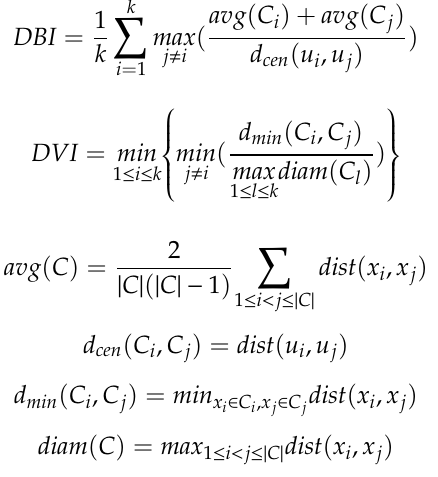
ADIK+K-means; ( d ) proposed method. ( c ) ADIK + K-means; ( d ) proposed